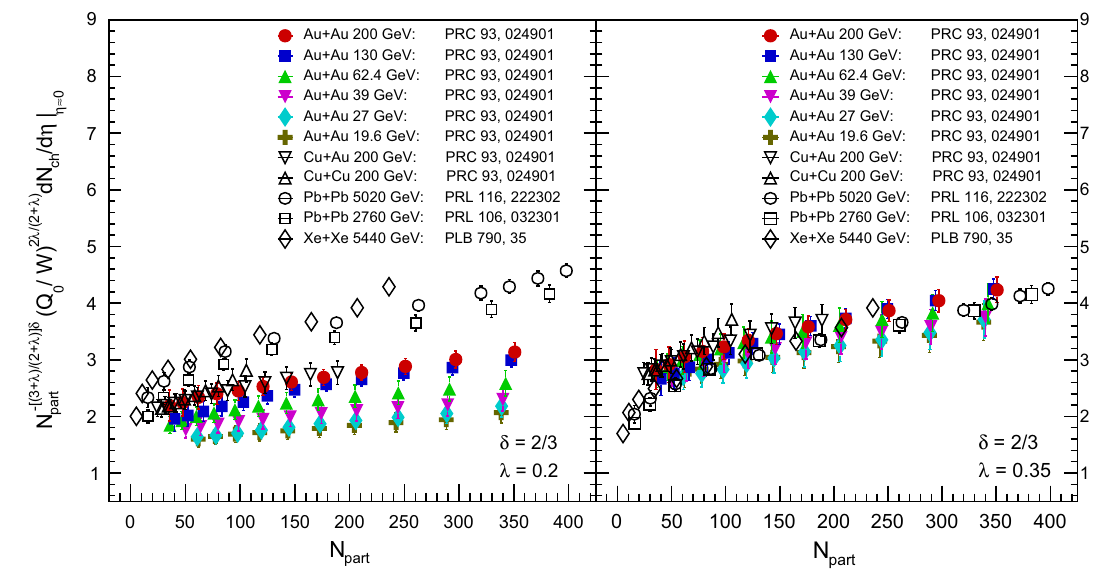
Fig. 4 Scaled multiplicity density (14) for charged particles at λ = 0 . 2 and λ = 0 . 35 as a function of N